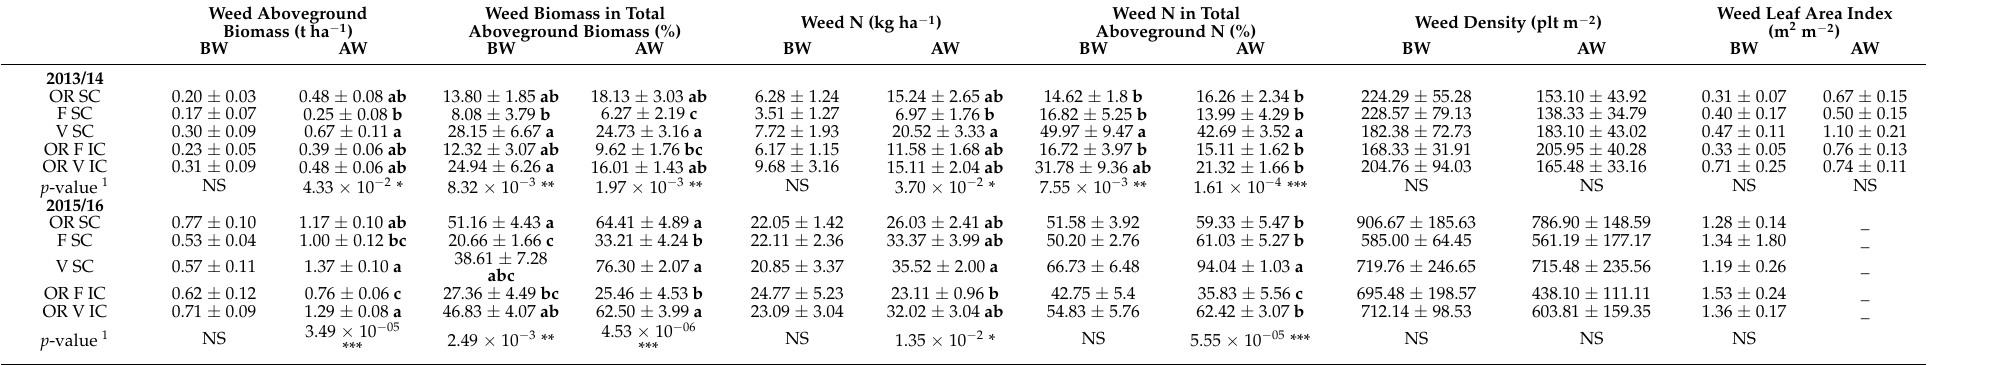
Means within each column and experimental year with different letters are significantly different ( p < 0.05). NS: Means were not significantly different. ***, **, *, indicate significant differences among species at p < 0.001, p < 0.05, p < 0.01, respectively. 1 p -values (analysis of variance ANOVA Type III, sum of squares, α = 0.05). “_ “: unavailable